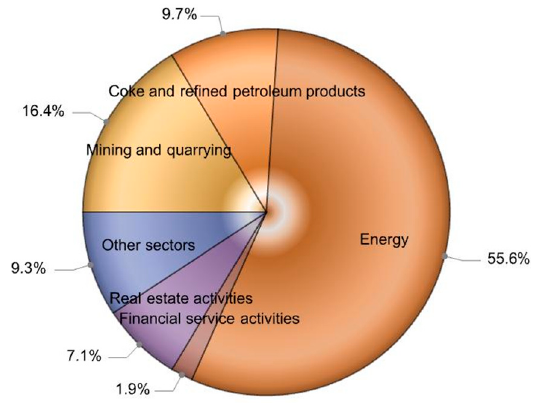
Figure 1. The contribution of costs to energy prices per industry of